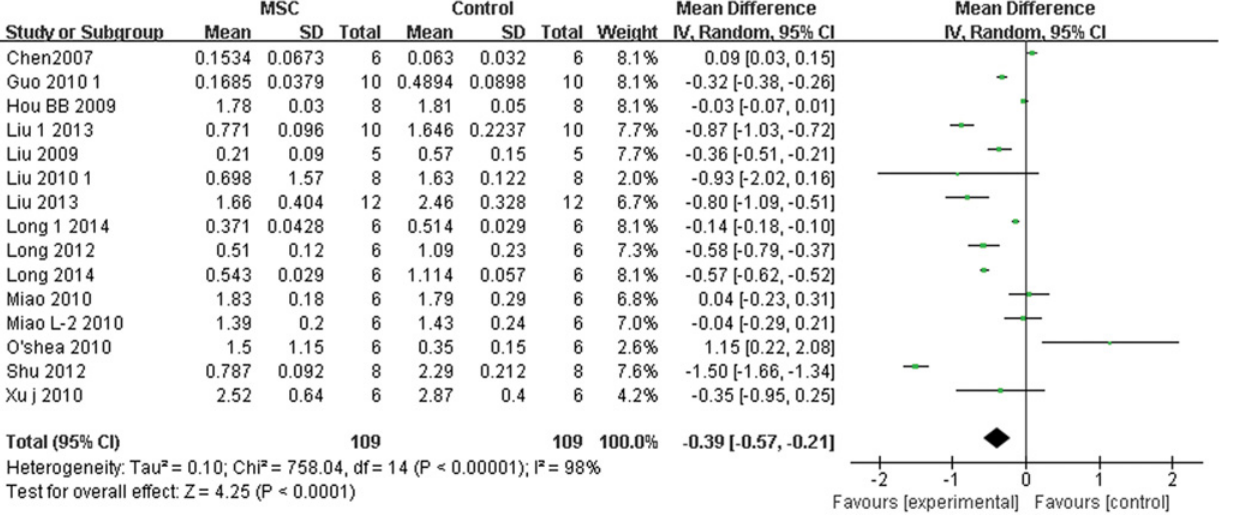
Fig 2. Forest plot showing the impact of mesenchymal stem cell (MSC) therapy on neointima/media, compared with controls. Abbreviations: SD = standard deviation, IV = independent variable, 95% CI = 95% confidence interval.